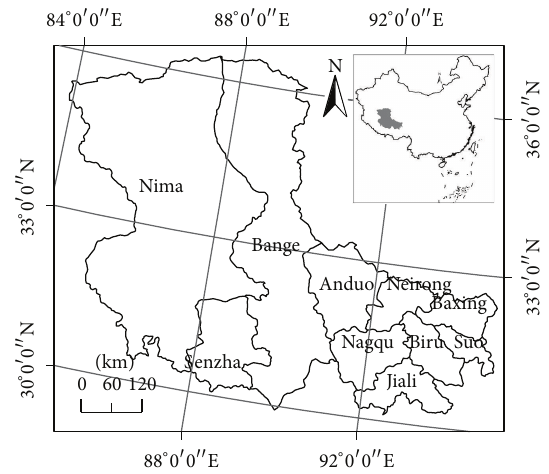
Figure 1: Spatial location of Silingco watershed